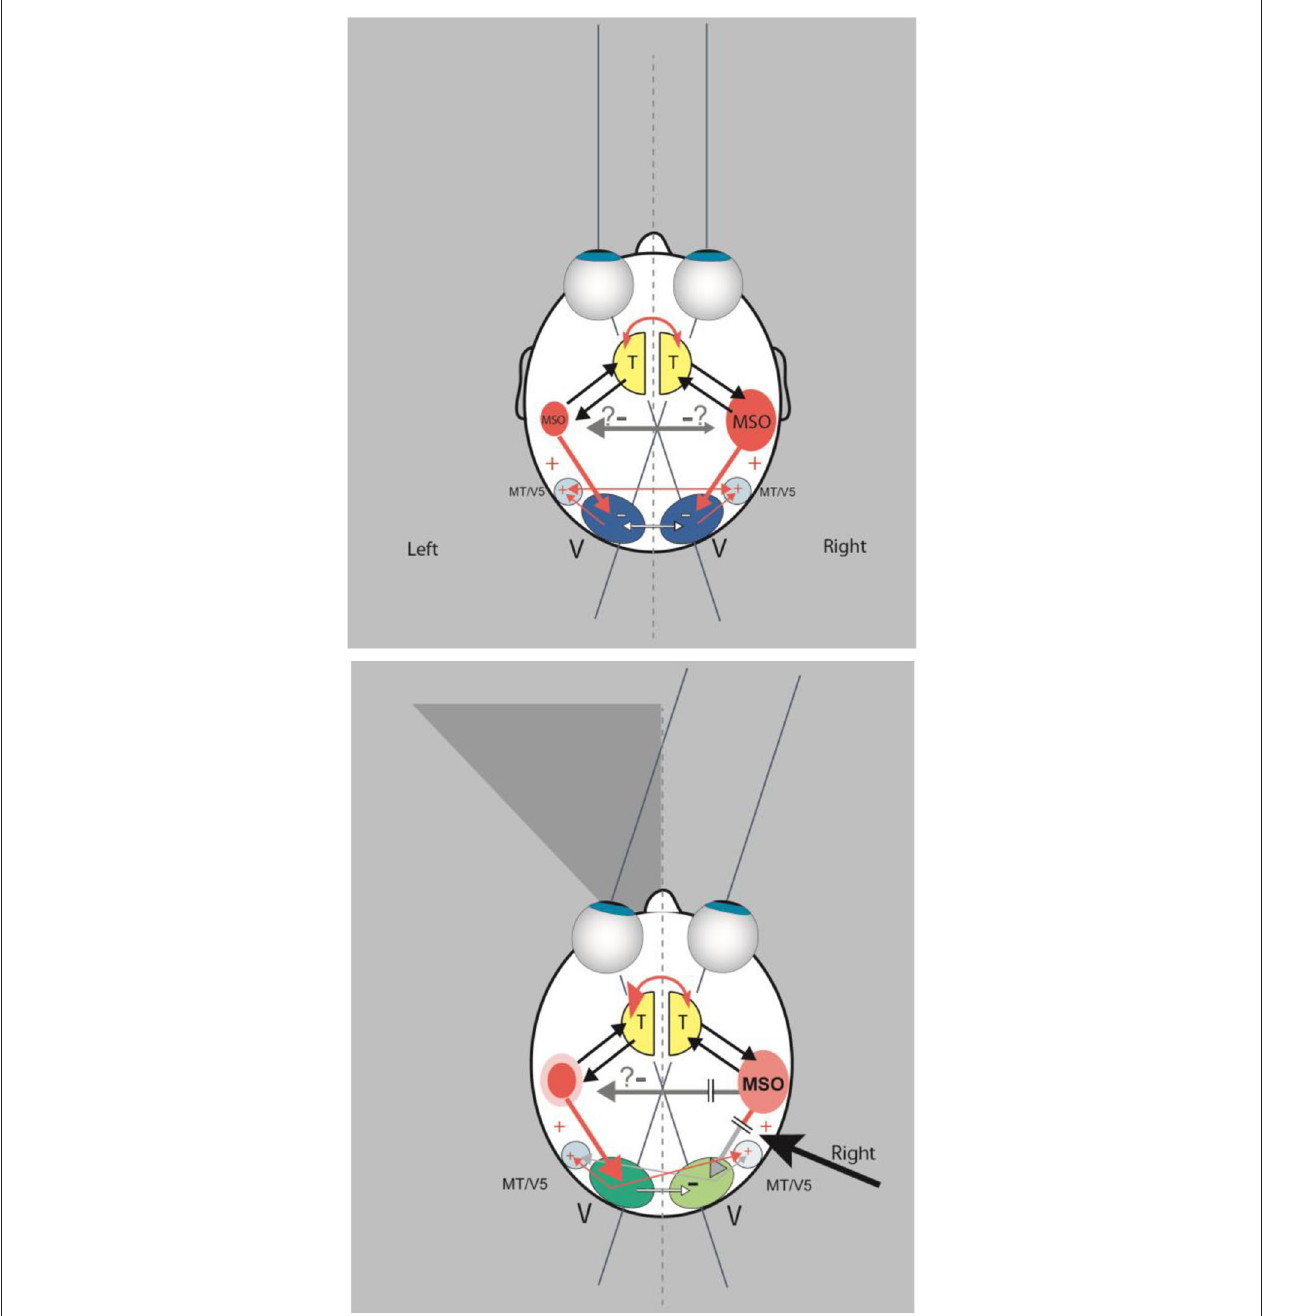
FIGURE 4 | (Top) In this scheme a double organization of the spatial attention and orientation center, represented by an “MSO” (multisensory orientation) in each hemisphere, is assumed, as is a dominance of the right hemisphere . Interhemispheric transcallosal connections are inhibitory. The MSO receives vestibular and somatosensory input from the thalamus (T) and directs visual attention by excitatory connections to the ipsilateral or contralateral visual cortex (V). The schematic drawing shows also transcallosal connections between the visual cortices. They are mainly inhibitory (white arrows) and to a lesser extent excitatory (thin red arrows) for bilateral activation of the motion-sensitive areas MT/V5.